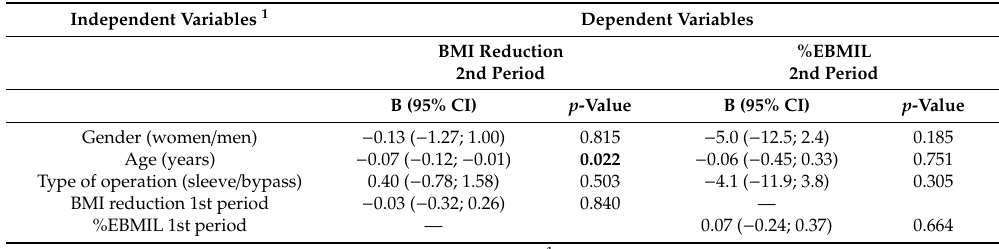
Table 4. Linear regression analyses with BMI reduction and %EBMIL in the second treatment period as dependent